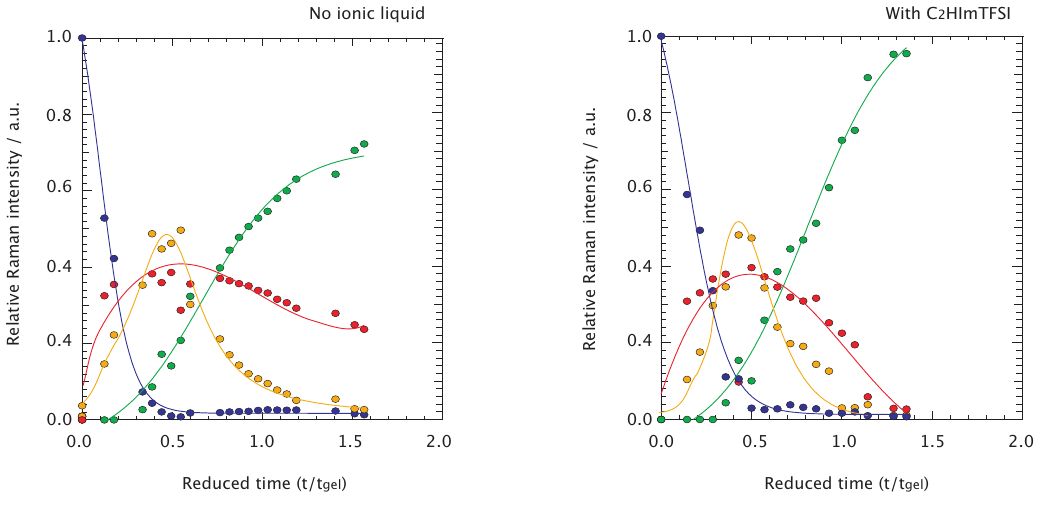
Figure 4. Relative Raman contributions to the spectral range 400–800 cm − 1 from OH-substituted TMOS (blue), monomeric (red), linear (yellow), and cyclic (green) species, for no ionic liquid ( left ) and for the C HImTFSi ionic liquid added ( right ) 2